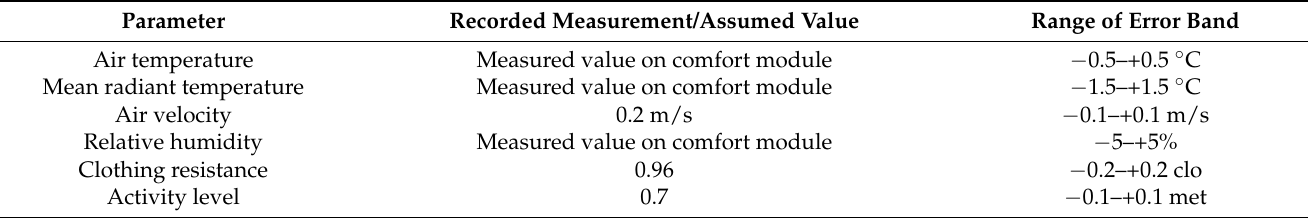
Table 4. Assumed ranges of values for calculating uncertainty in